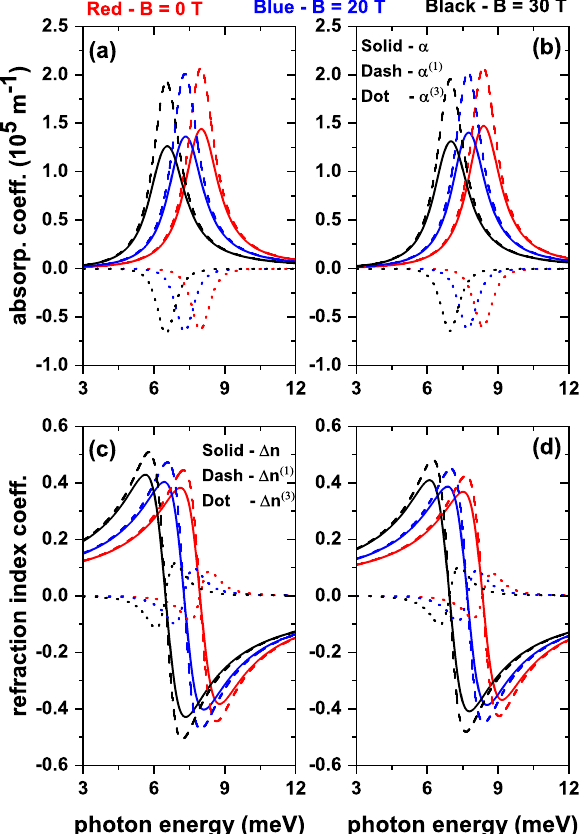
Figure 9. The total (solid line), linear (dashed line), and nonlinear (dotted line) optical absorption coefficient ( a , b ), and the total (solid line), linear (dashed line), and nonlinear (dotted line) relative changes in the refractive index coefficient ( c , d ) as functions of the incident photon energy in a ZnS/CdS/ZnS spherical core/shell/shell quantum dot, for three values of the magnetic field: zero (red line), 20 T (blue line), and 30 T (black line). The results are without ( a , c ) and with ( b , d ) donor impurity at the center in the QD. Calculations are with R 1 = 4nm, R 2 = 11nm, and R 3 = 12nm. The optical transition is between the states | 1 (cid:105) → | 2 (cid:105) , with m = 0 and without external electric field